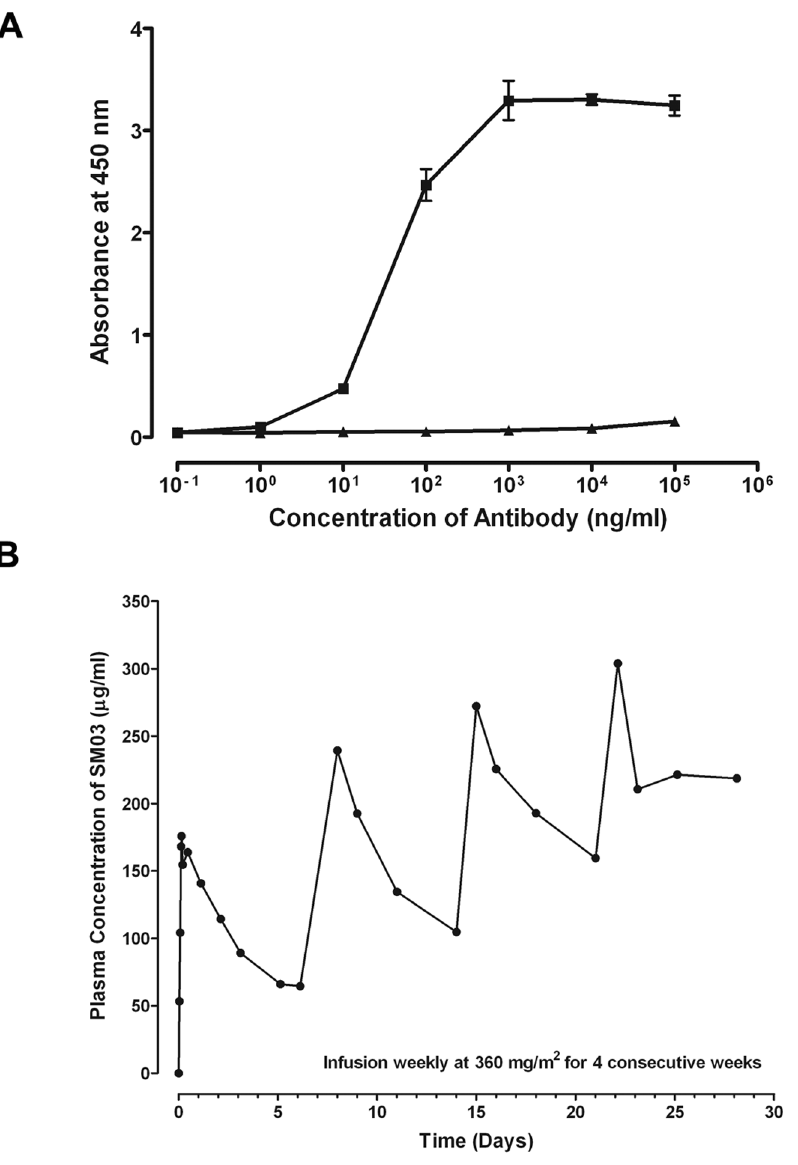
Figure 7. Pharmacokinetic measurement of chimeric anti-CD22 SM03 by capture ELISA. The anti-Id scFv Hc5 was coated onto 96-well ELISA plate at 10 m g/mL, and then incubated at 37 u C for 1 h with (A) various amounts of chimeric anti-CD22 SM03 ( & ) or control chimeric anti-TNF a N009 ( m ) to establish a standard calibration curve; (B) blood samples of a lymphoma patient treated with weekly infusion of 360 mg/m 2 of chimeric anti-CD22 SM03 to determine residual SM03 in plasma as described in Methods. The captured SM03 antibodies were then detected by incubating with secondary HRP-conjugated goat anti-human IgG Fc antibody. Data shown is a representative showing the typical pharmacodynamic measurement of circulating SM03 in patients undertook the Phase I clinical trial. Anti-idiotype antibodies are antibodies that are specific for the unique antigenic determinant, also known as the idiotype, of the immunizing antibody. The immunizing antibody is usually referred to as Ab1, and the anti-idiotype antibody as Ab2. There are three categories of Ab2 antibodies: (1) Ab2 a antibodies are those that recognize the idiotype on Ab1 but not the antigen- binding site; (2) Ab2 b antibodies recognize epitopes within the antigen binding site of Ab1 with structure resembling the internal image of the nominal antigen; (3) Ab2 c antibodies bind to the epitopes within the ABS without the structural resemblance of an internal image [25].